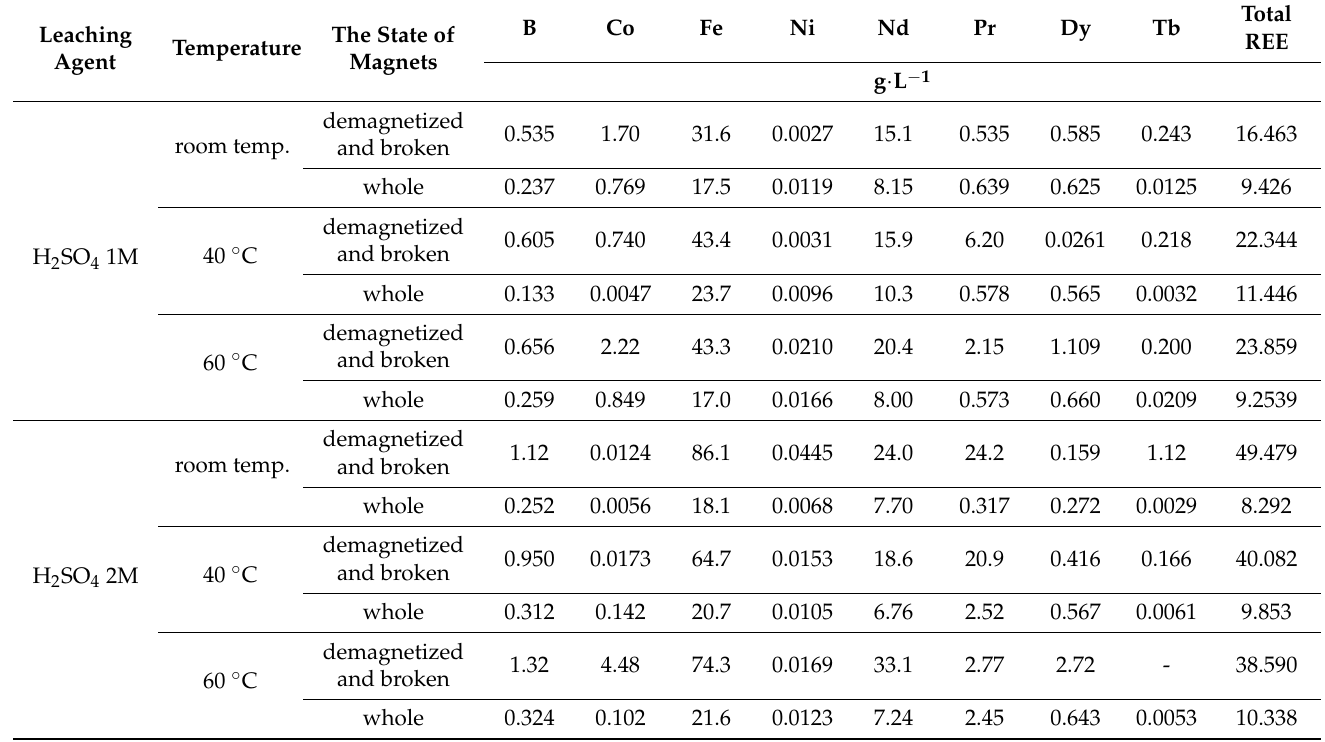
Table 5. Concentration of metal ions in the solutions obtained after the leaching of magnets in sulfuric acid for 7 h. Leaching The State of Temperature Agent